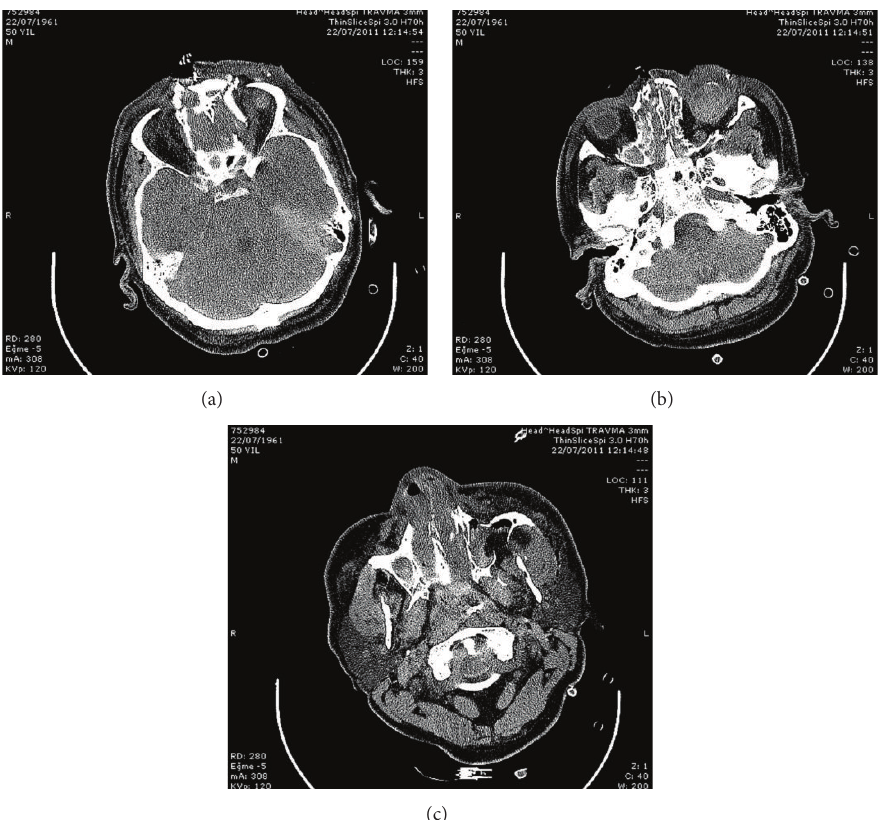
Figure 1: Head CT showing multiple fractures of the face. The patient suffered from depression fracture in the frontal (a), orbital and nasal (b), and maxillary (c) bones.